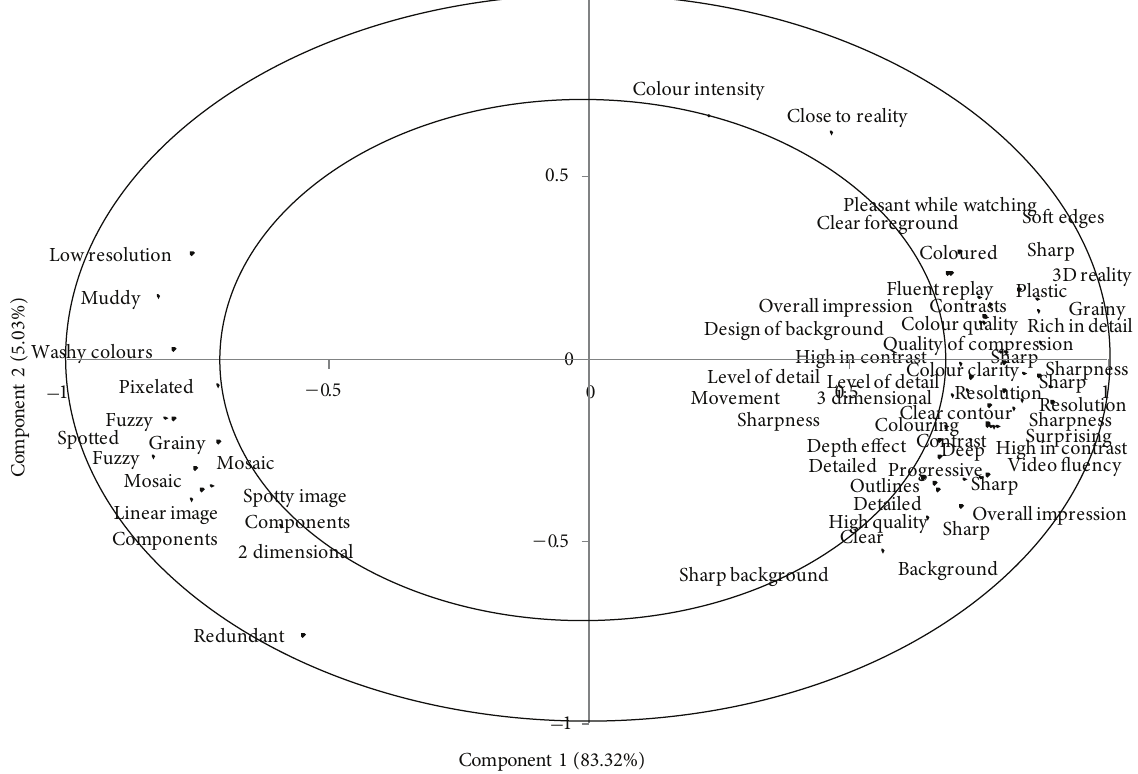
Figure 15: Correlation plot of the experienced quality factors. The figure shows the first two principal components of the GPA model and the correlation of the attributes with these components. Inner and outer circles show 50% and 100% explained variance,